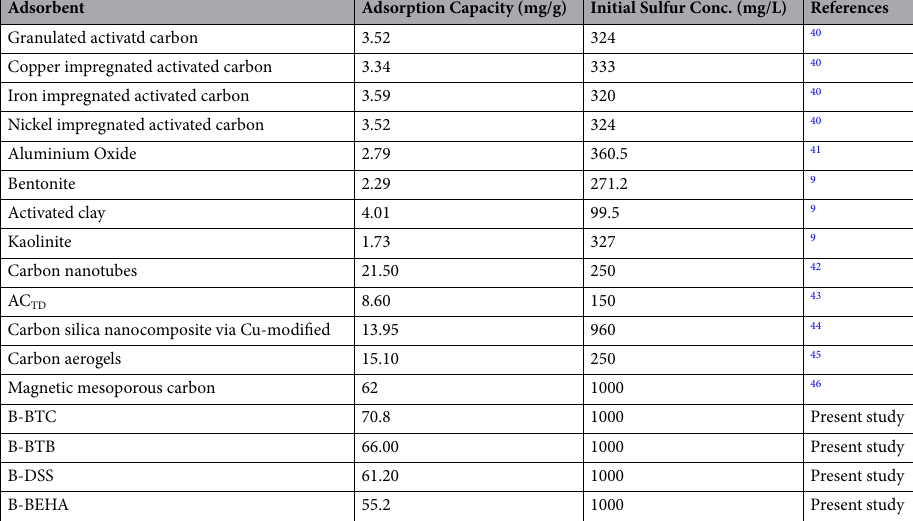
Table 5. Comparison of adsorption capacity (mg/g) of various adsorbents for desulfurization.